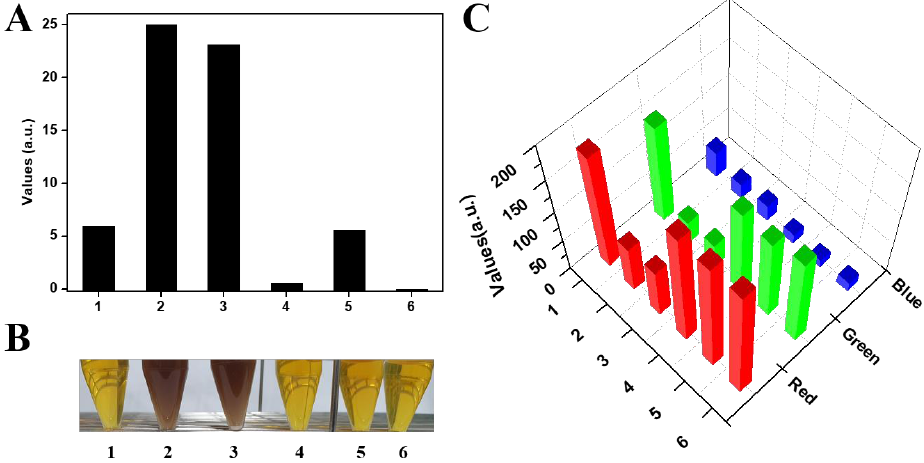
Figure 5. ( A ) Spectral responses for detection of hydrazine decomposition in the presence of H 2 O 2 (0.2 M) and different metal ions (32 ppm respectively); ( B ) color changes for different metal ions; and ( C ) RGB profiles of different metal ions. 1 represents the control and 2, 3, 4, 5, and 6 represent Fe 2+ , Fe 3+ , Mn 2+ , Cr 6+ , and Ni 2+ . The concentration of p -dimethylaminobenzaldehyde used was 4 × 10 −6 M.